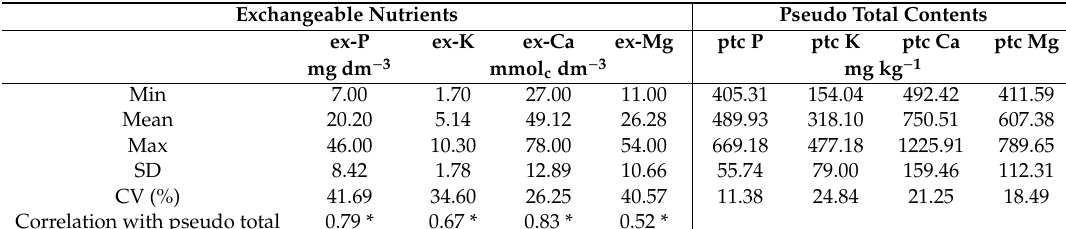
Table 1. Descriptive statistics of exchangeable and pseudo total nutrients and the correlation between the respective nutrients.